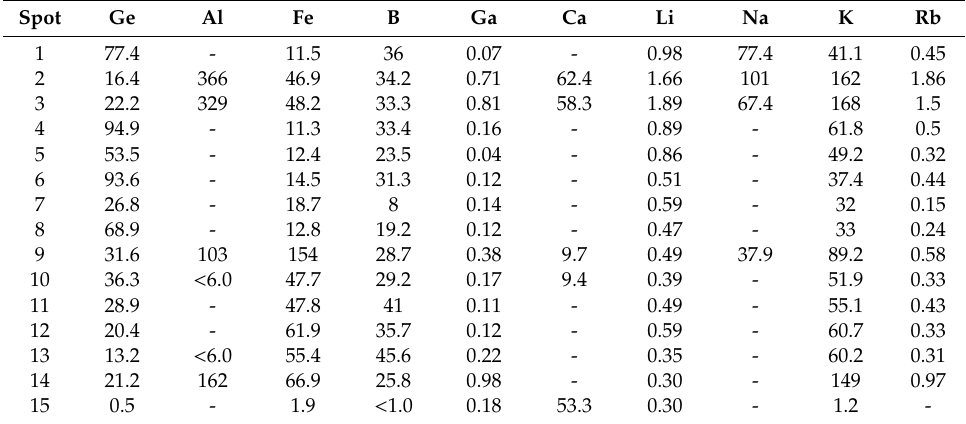
Figure 16. ( a ) Trace-element data from ICP-MS analyses of di ff erent zones (1, 3 = chalcedony; 2, 4 = macrocrystalline quartz) in an agate from St. Egidien, Saxony (Germany) compared to the composition of the rhyolitic host rock (the circles mark the areas of chemical analyses; nd—not detected); ( b ) chondrite-normalized REE distribution patterns (normalization according to data of Mason [127]) of the same agate zones shown in ( a ). Table 2. Concentrations of trace elements (in ppm) from LA-ICP-MS local chemical analyses of a profile across an agate from St. Egidien, Saxony (Germany) (data from Götze et al. [68]); the numbers relate to the analytical points indicated in Figure